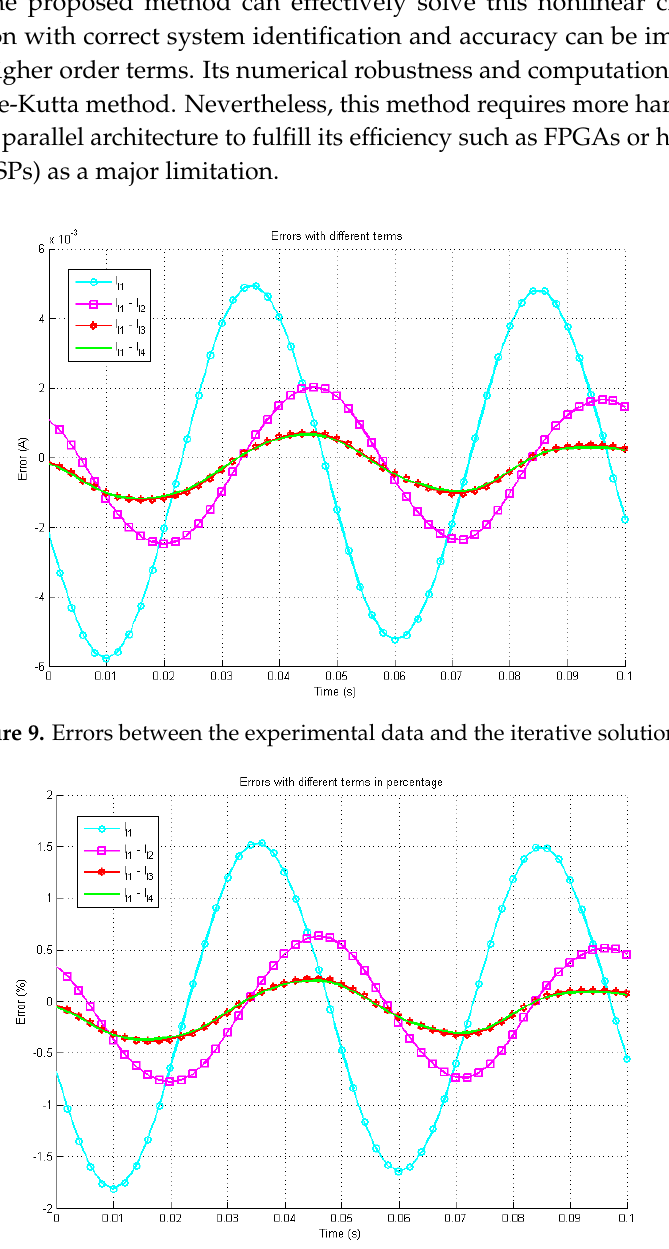
Figure 10. Errors between the experimental data and the iterative solutions by